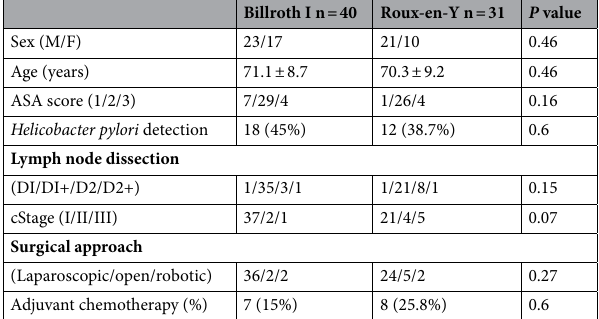
Table 1. Characteristics of patients with BI and RY reconstruction. ASA American Society of Anesthesiologists, BI Billroth I, RY